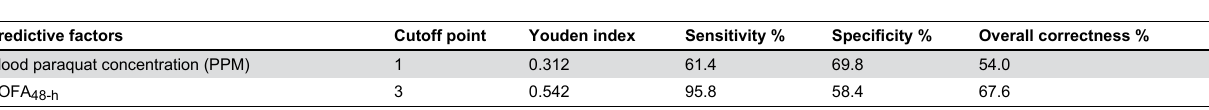
Table 6. Prediction of ARDS